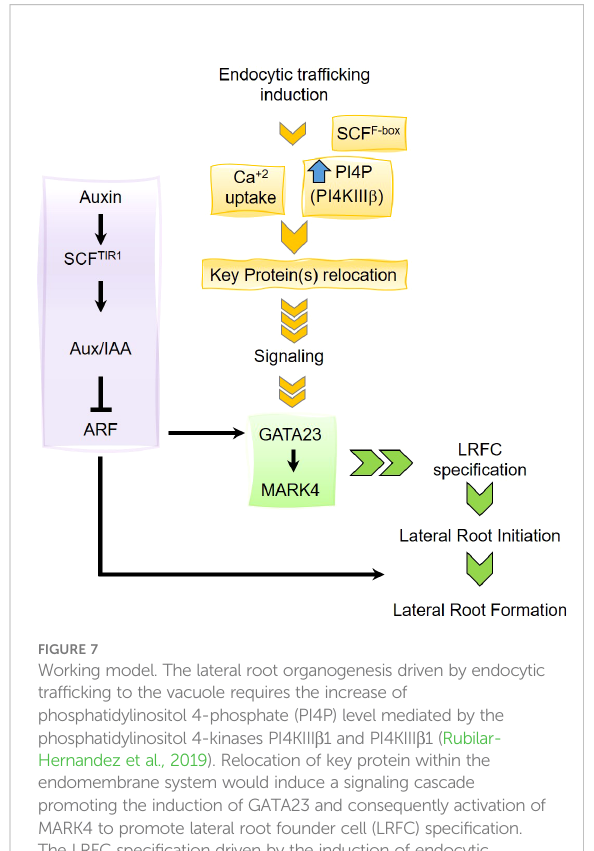
FIGURE 7 Working model. The lateral root organogenesis driven by endocytic traf fi cking to the vacuole requires the increase of phosphatidylinositol 4-phosphate (PI4P) level mediated by the phosphatidylinositol 4-kinases PI4KIII b 1 and PI4KIII b 1 (Rubilar- Hernandez et al., 2019). Relocation of key protein within the endomembrane system would induce a signaling cascade promoting the induction of GATA23 and consequently activation of MARK4 to promote lateral root founder cell (LRFC) speci fi cation. The LRFC speci fi cation driven by the induction of endocytic traf fi cking requires Ca +2 entrance and the function of a SCF complex although the F-Box is unknown yet. This pathway is distinctive from the auxin-driven lateral root primordia